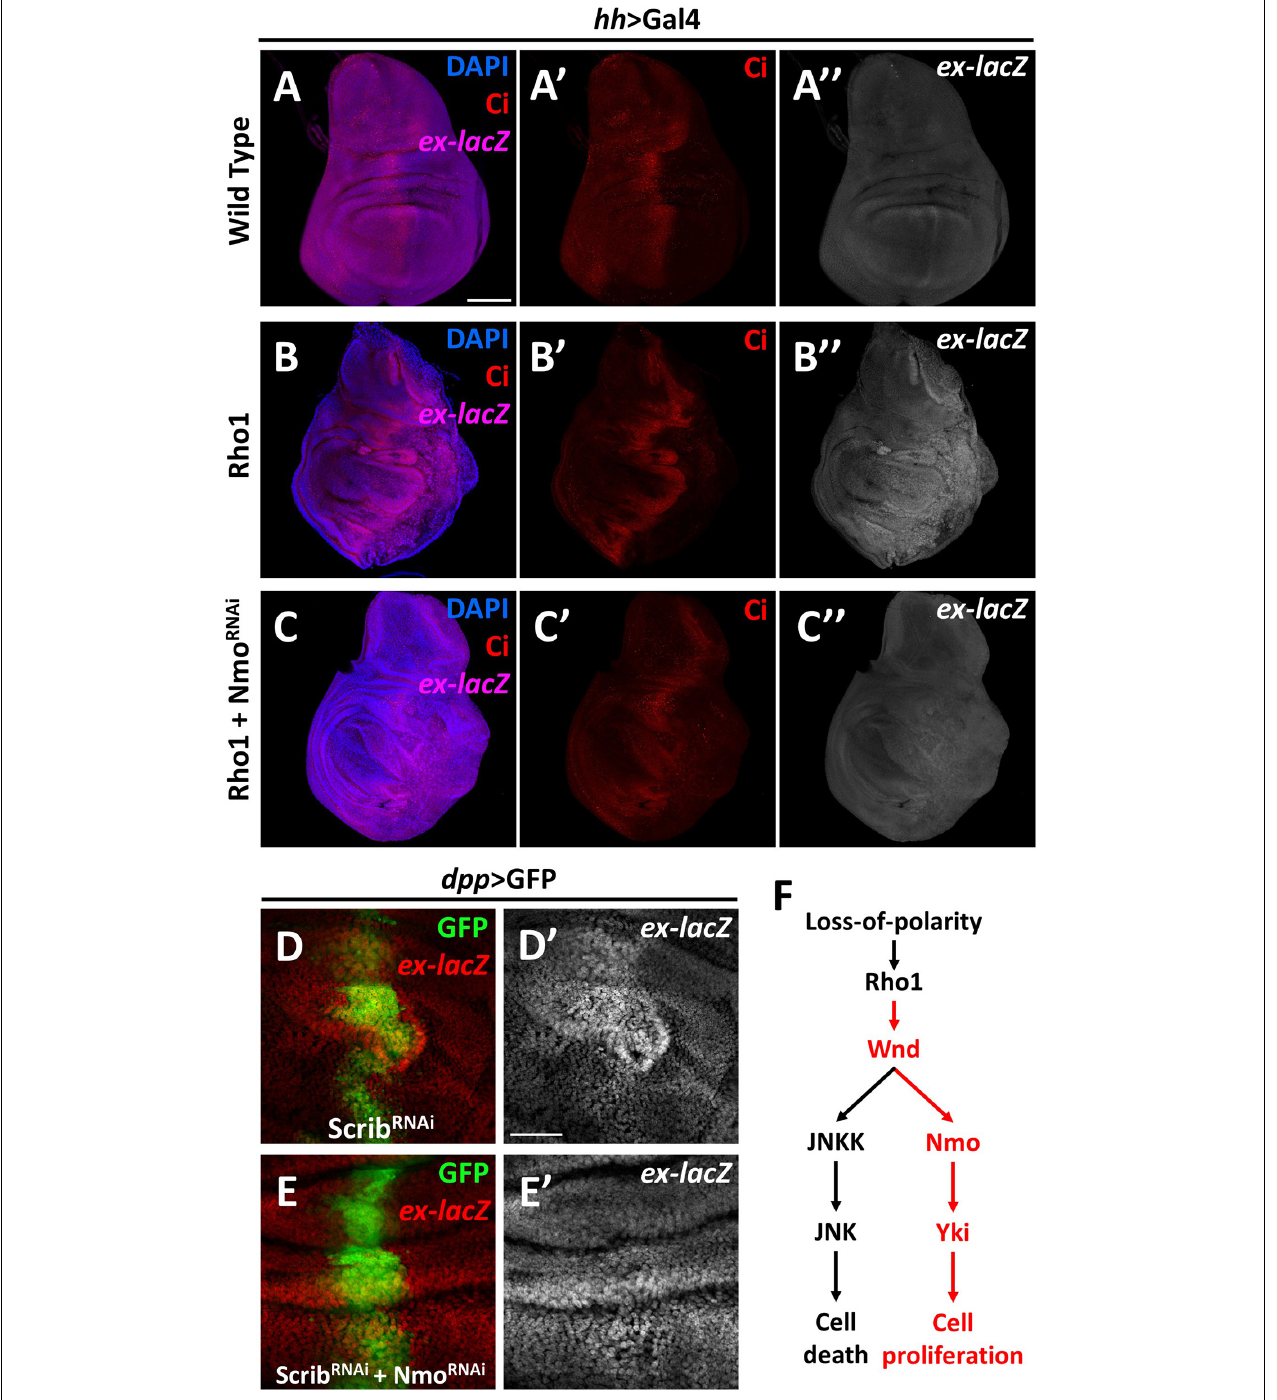
FIGURE 4 | Nmo is essential for loss-of-cell polarity induced growth and Yki activation Wing imaginal discs from third instar larva are shown. (A–C (cid:48)(cid:48) ) Gene or RNAi is expressed driven by hh -Gal4 in the posterior region (opposite to ci-stained zone). Compared with wild type control (A–A (cid:48)(cid:48) ) , expression of Rho1 elevates ex-lacZ expression level (B–B (cid:48)(cid:48) ) , which is suppressed by nmo knockdown (C–C (cid:48)(cid:48) ) . (D–E (cid:48) ) RNAi lines are driven by dpp -Gal4 in the GFP positive region. scrib knockdown caused ex transcription upregulation (D,D (cid:48) ) is rescued by nmo knockdown (E,E (cid:48) ) . (F) A schematic model showing the regulation of Hippo signaling by the Wnd-Nmo axis. Scale bars, 50 µ